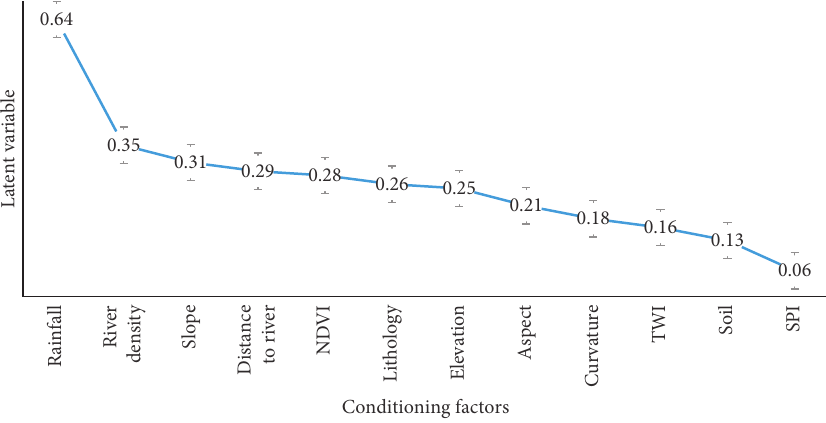
Figure 10: Important flood factors selected by LSA